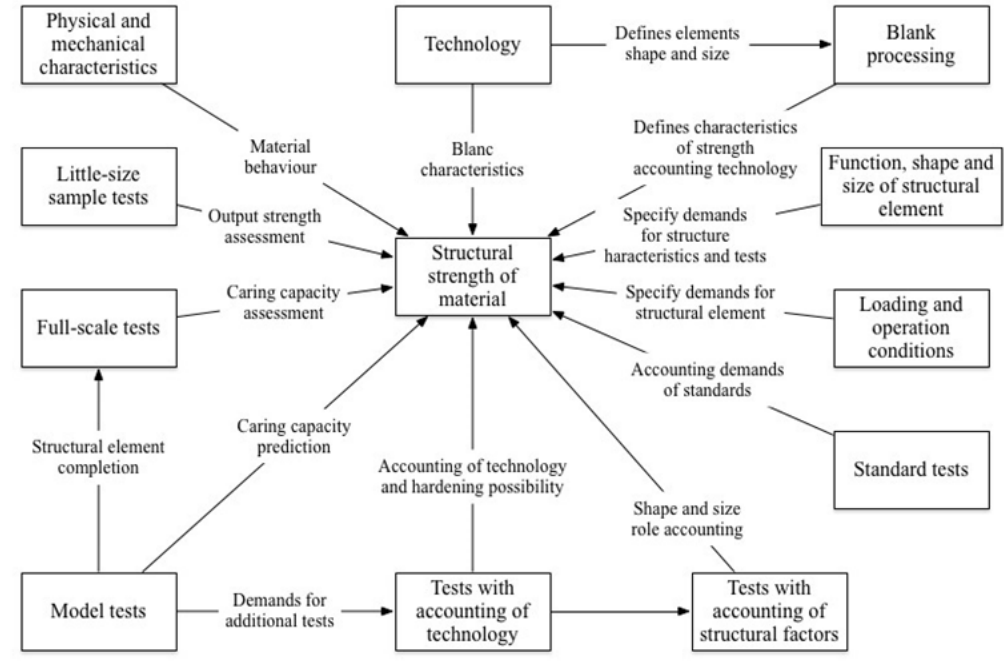
Fig. 1 Conceptual graph of the subject area “Structural strength of